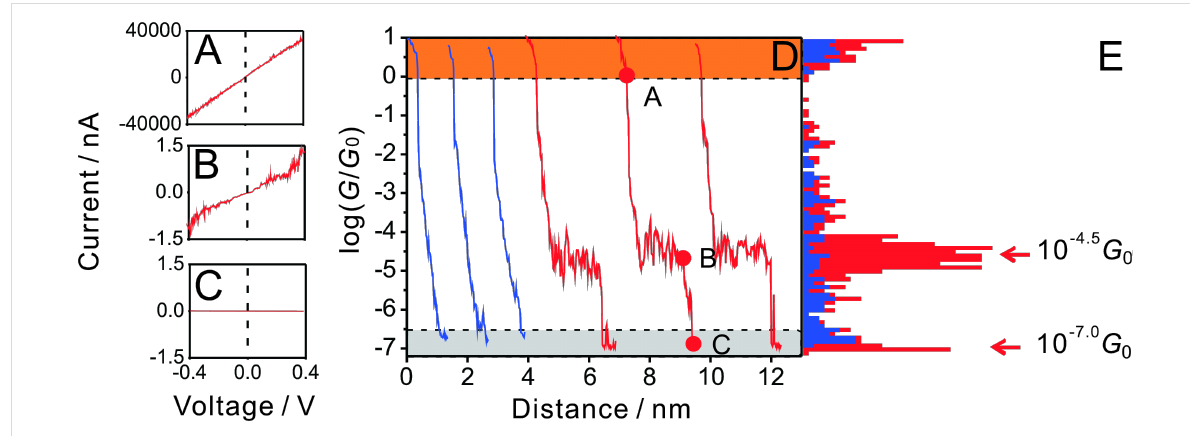
Figure 5: (A–C) Individual current–voltage curves of (A) a gold–gold contact, (B) a gold| AC |gold molecular junction, and (C) tunneling response through the solvent upon approaching the noise level. (D) Traces constructed from the slopes of individual I–V curves as recorded simultaneously during a slow stretching half cycle, with (red traces) and without (blue traces) the formation of a molecular junction. The red circles indicate the posi- tions where the I–V curves shown in panels (A) to (C) were recorded. (E) Conductance histogram as constructed from the data points plotted in panel D. Other conditions: 0.1 mM in THF/decane (v:v = 1:4), Ar